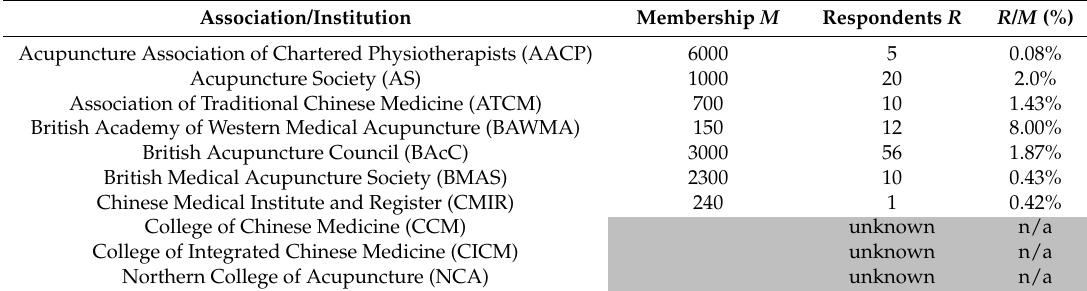
Table 1. Acupuncture Associations and training institutions informed about the survey, showing percentage of association members who completed the